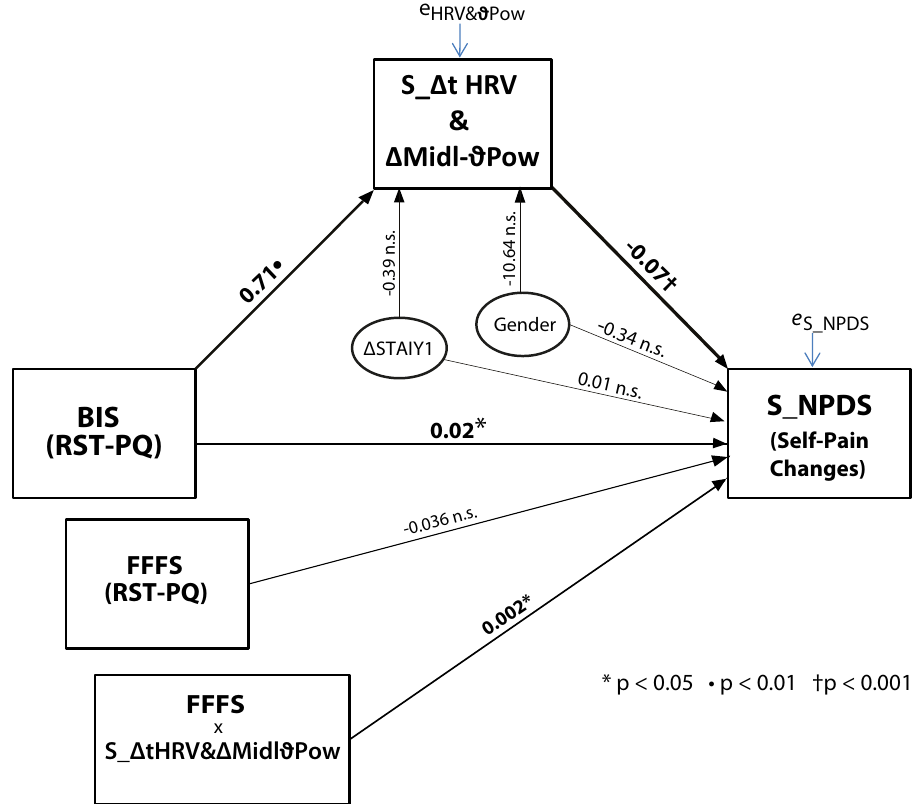
Figure 4. Conditional process model depicting the causal influence of BIS on the outcome S_NPDS with the "S_∆tHRV & ∆Midl-ϑPow" factor as a potential mediator and with FFFS as a moderator of the S_∆tHRV & ∆Midl-ϑPow influence on S_NPDS. The thickness of the arrows indicates the strength of the link between variables. Gender and State-Anxiety changes (∆STAIY1) are included as covariates.